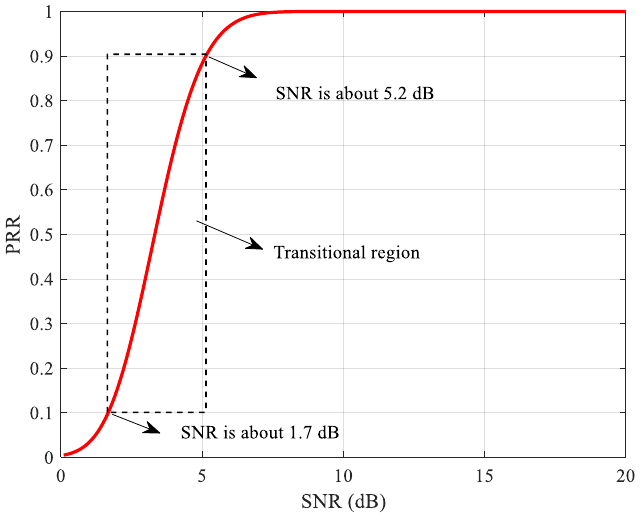
Figure 1. Theoretical Model of SNR and PRR.